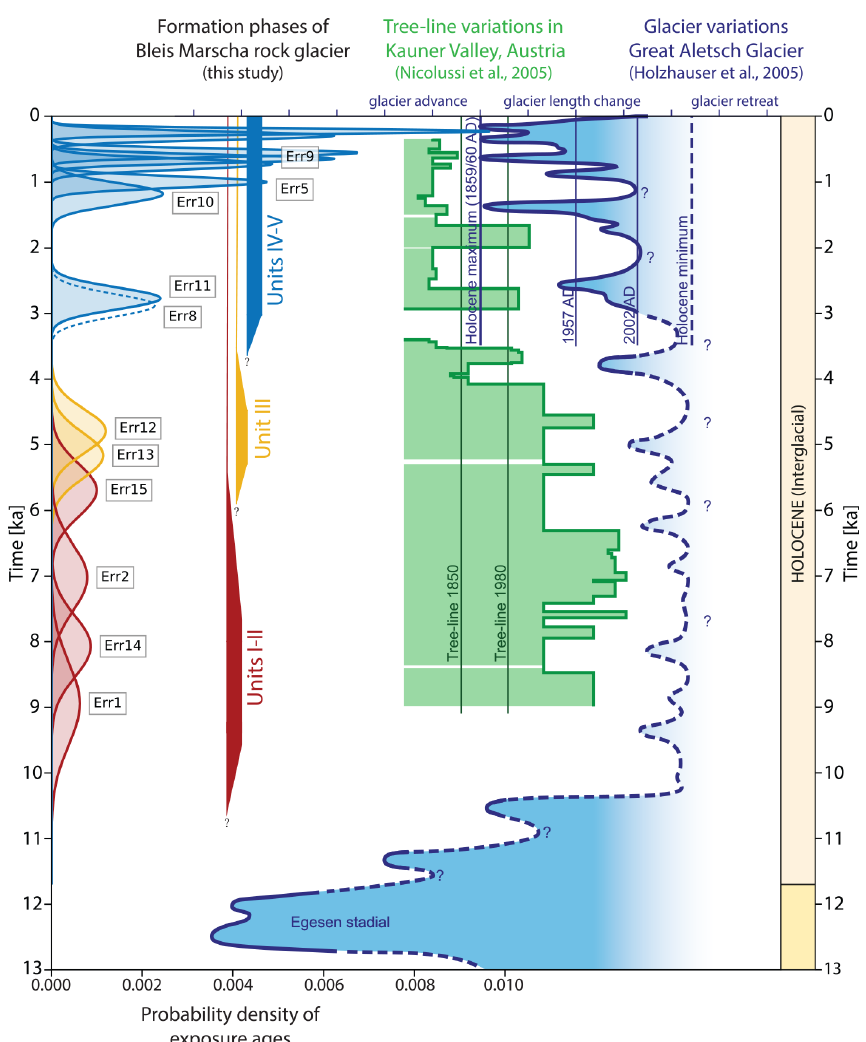
Figure 11. Bleis Marscha rock glacier formation phases in the framework of the climate evolution in the Central–Eastern Alps during the Younger Dryas and the Holocene (modified from Ivy-Ochs et al., 2009; Singeisen et al., 2020). Climate proxies are Great Aletsch glacier length variations (modified from Holzhauser et al., 2005) and Kauner valley tree-line variations (Nicolussi et al., 2005). Bleis Marscha exposure ages are plotted as probability density functions (in ka; uncertainties are 1 σ external errors). We interpret three distinct generations: Early Holocene ( ∼ 8 . 9–8.0ka, after retreat of the Egesen glaciers of the Younger Dryas cold phase) of low-elevation units I–II, Middle Holocene ( ∼ 5 . 2–4.8ka, after the Middle Holocene warm period) of unit III, and Late Holocene until present (since ∼ 2 . 8ka, roughly coeval with Late Holocene cooling and glacier re-advances) of high-elevation units IV–V. The formation phases of the three Bleis Marscha rock glacier generations appear to correlate with Holocene climate